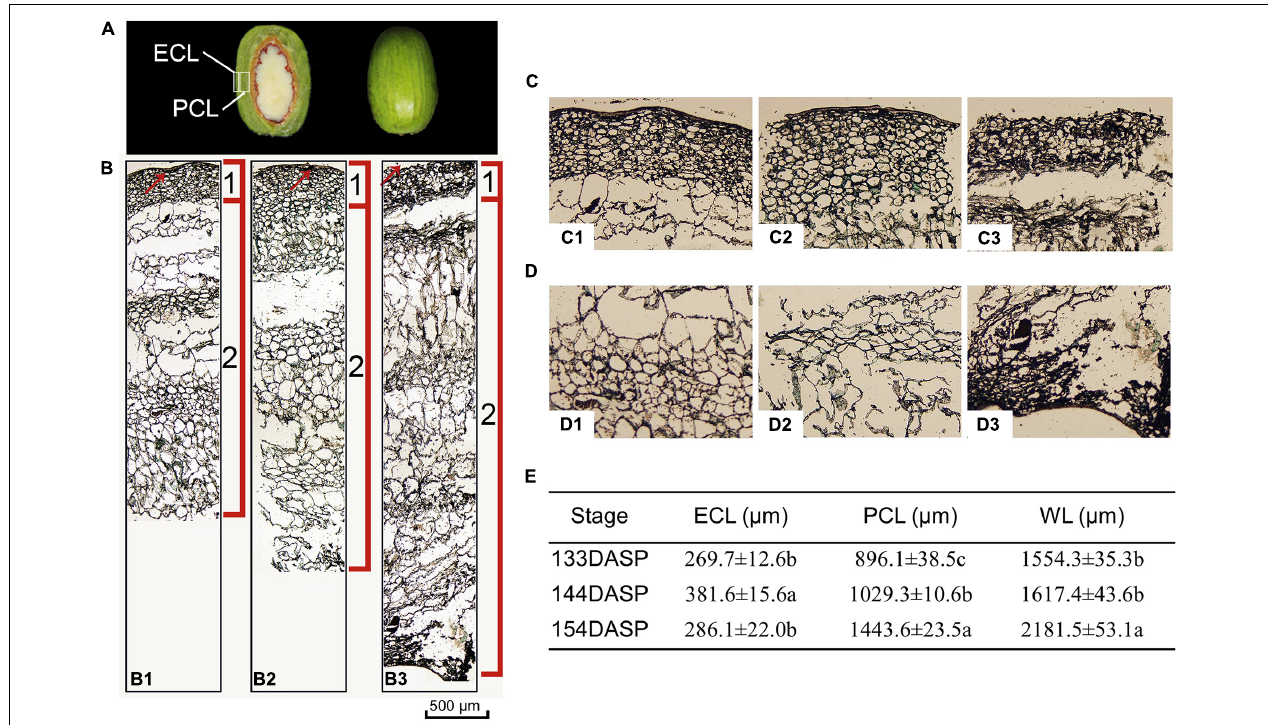
FIGURE 2 | Changes in light micrograph longitudinal sections of epidermal and parenchymatous aril cells in Torreya grandis during nut maturation. (A) Appearance of ECL (epidermal cell layer) and PCL (parenchymatous cell layer) in the aril. (B) Light micrograph longitudinal sections of whole aril. (B1–B3) Anatomical structural of the whole aril at 133, 144, and 154 days after seed protrusion (DASP), respectively; 1 indicates the epidermal cell layer; 2 indicates the parenchymatous cell layer; the red arrow indicates the cuticle. (C) Light micrograph of epidermal aril cells. (C1–C3) Anatomical structure of the epidermal cells layer at 133, 144, and 154 DASP, respectively. (D) Light micrograph of parenchymatous aril cells. (D1–D3) Anatomical structure of the parenchymatous cell layer at 133, 144, and 154 DASP, respectively. (E) Thickness of the ECL, PCL, and WL (whole layer). Different lowercase letters within a row indicate a significant difference at different growth stages by Duncan’s multiple range test ( P < 0.05). N =